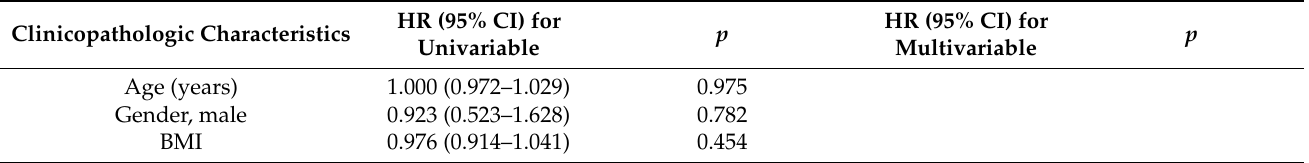
Table 4. Cox hazard analysis (univariable and multivariable) of clinicopathologic data for overall